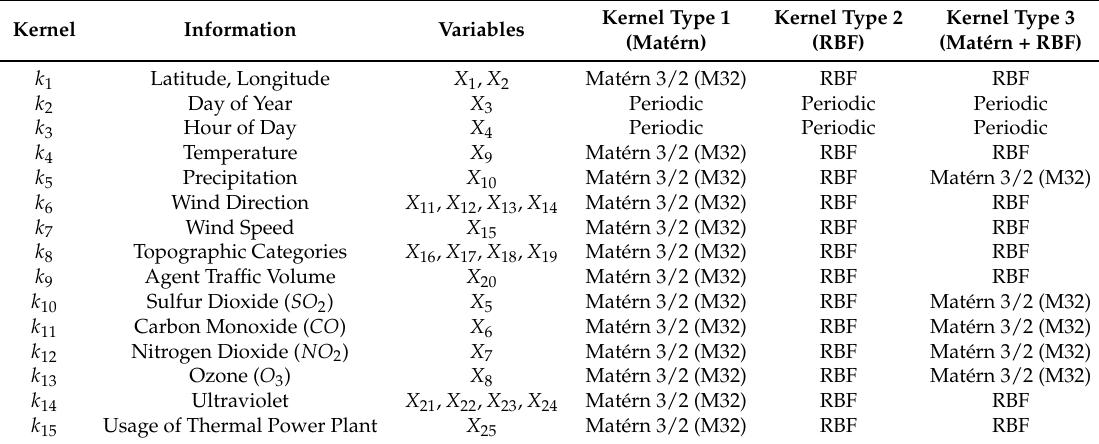
Table 3. Kernel design with respect to input